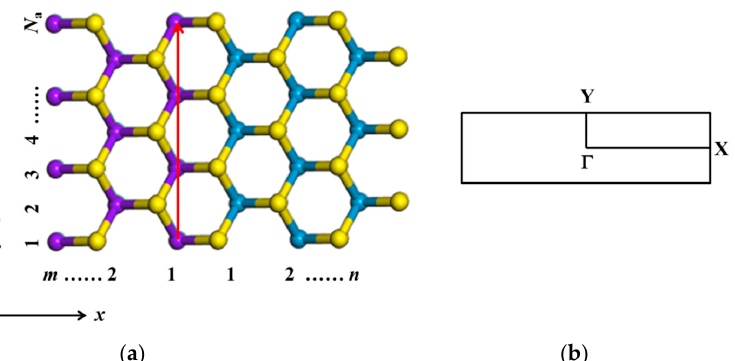
Figure 3. ( a )The structure of armchair MoS 2 -WS 2 superlattice nanoribbon. The m and n represent the components of MoS 2 and WS 2 in the lateral superlattice period. The x -axis and y -axis denote the period and width N a directions, respectively. ( b ) The high-symmetry points Γ , X and Y in Brillouin zone.